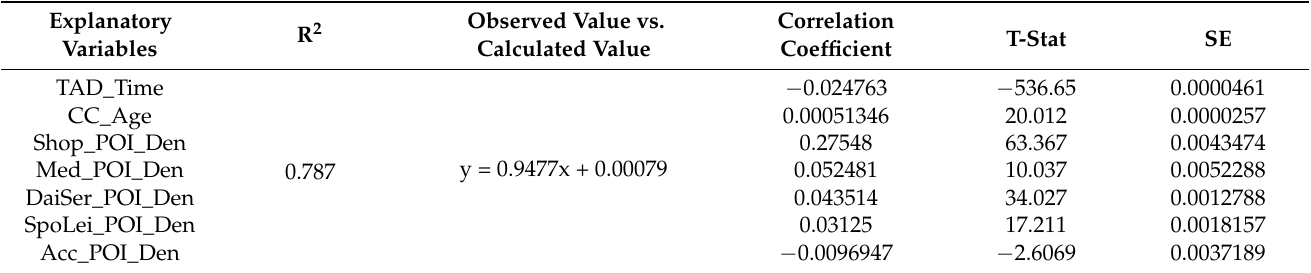
Table 5. Optimal model results for consumers under 40.